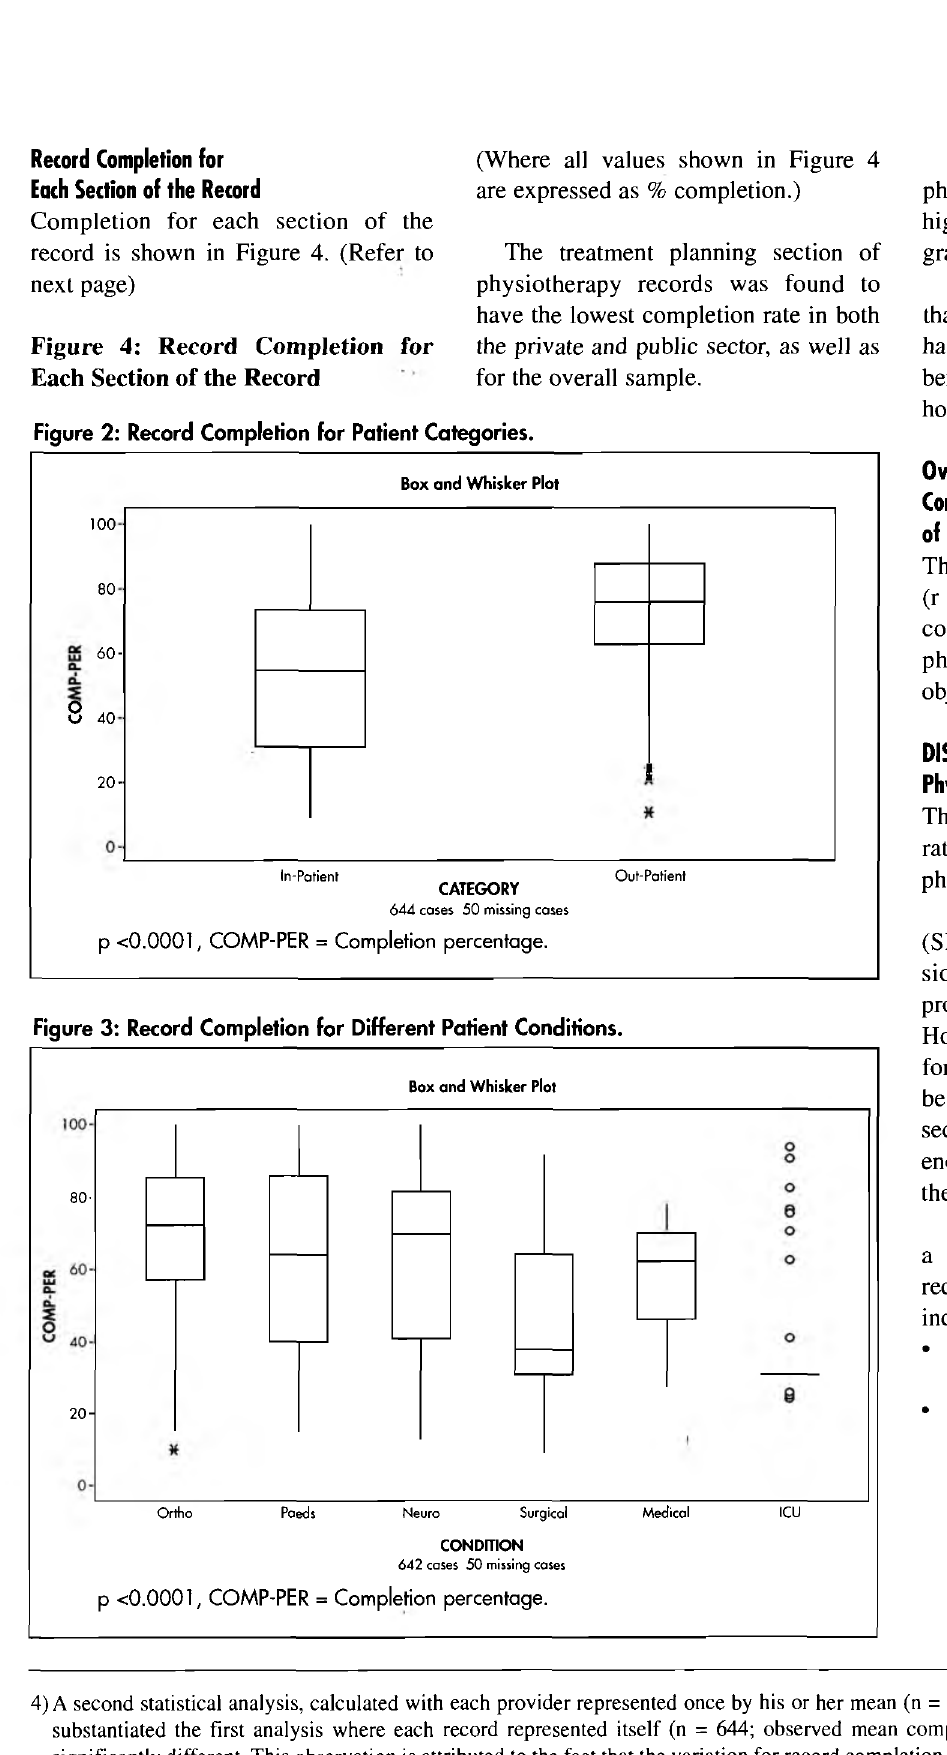
Figure 4: Record Completion for